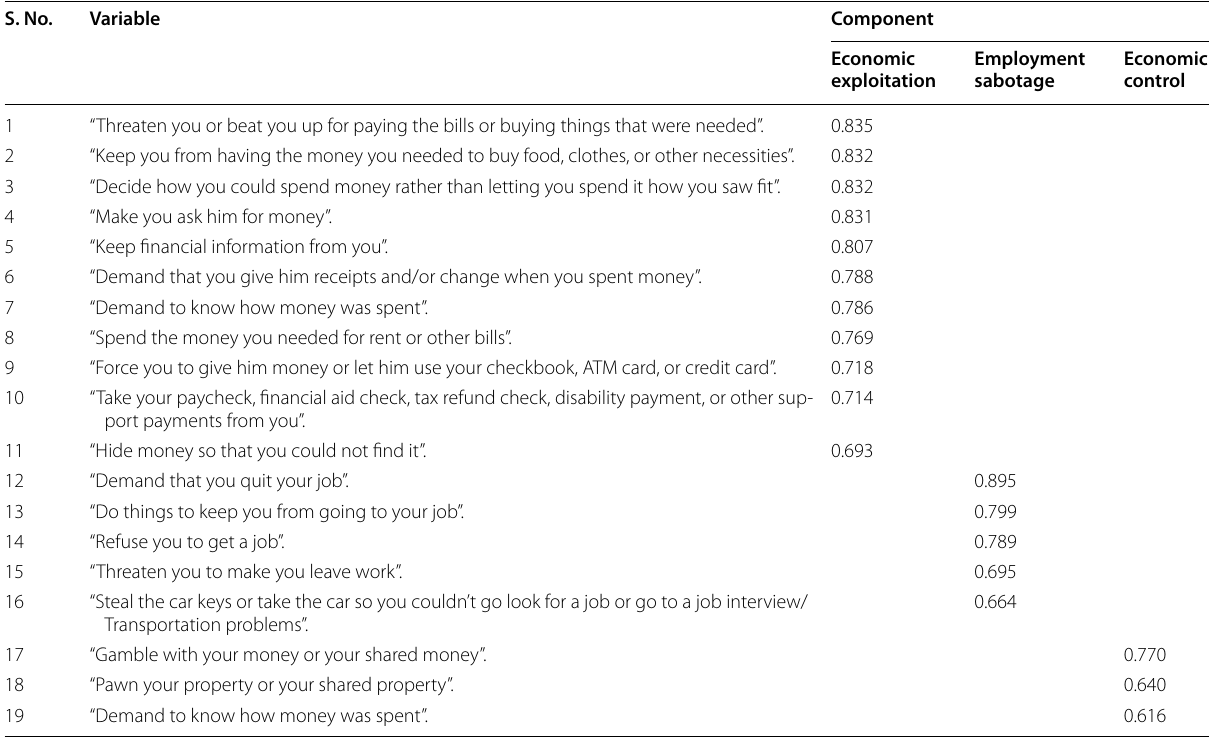
Extraction method: principal component analysis [29], and rotation method: varimax with Kaiser